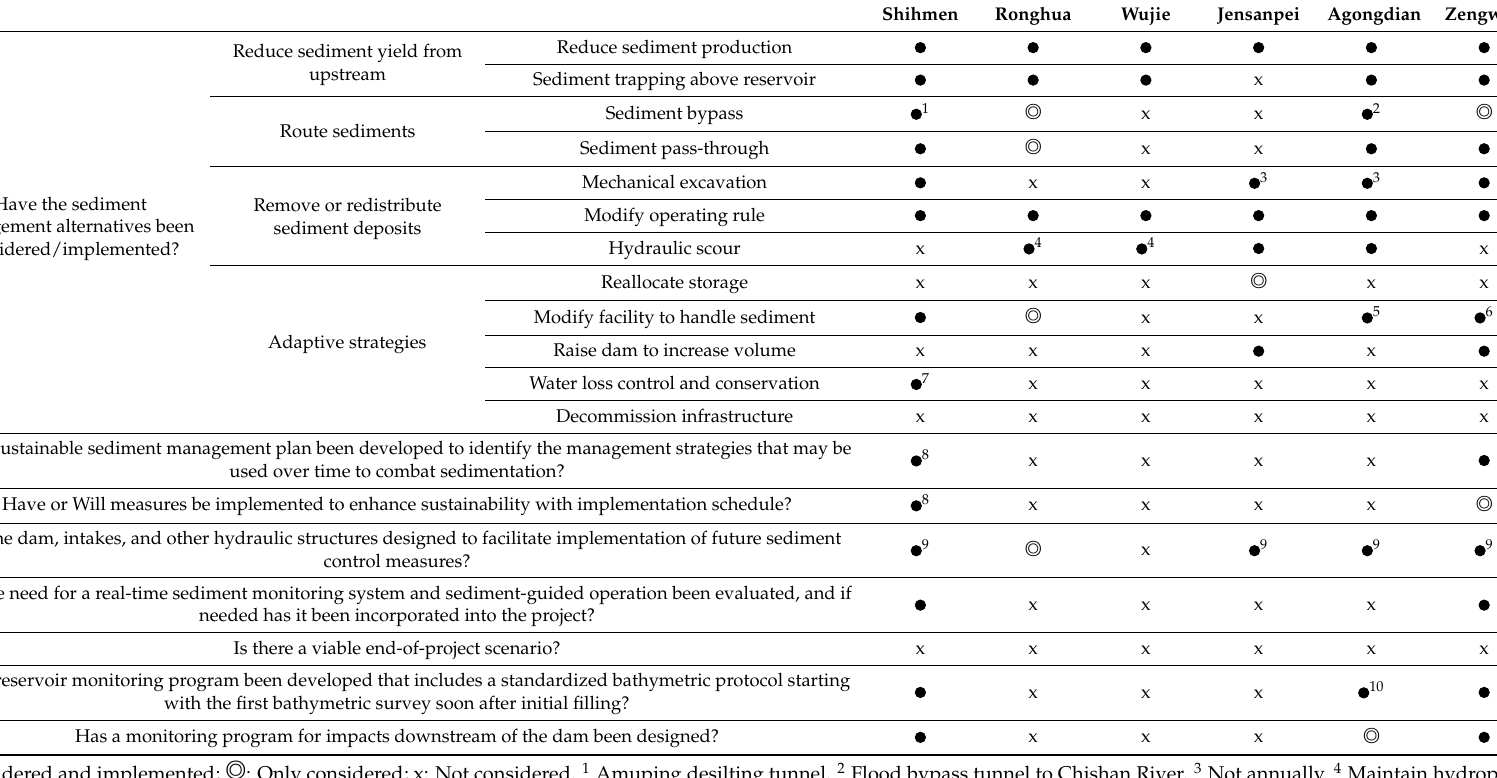
Figure 3. 9 After modification or renovation. 10 After reservoir